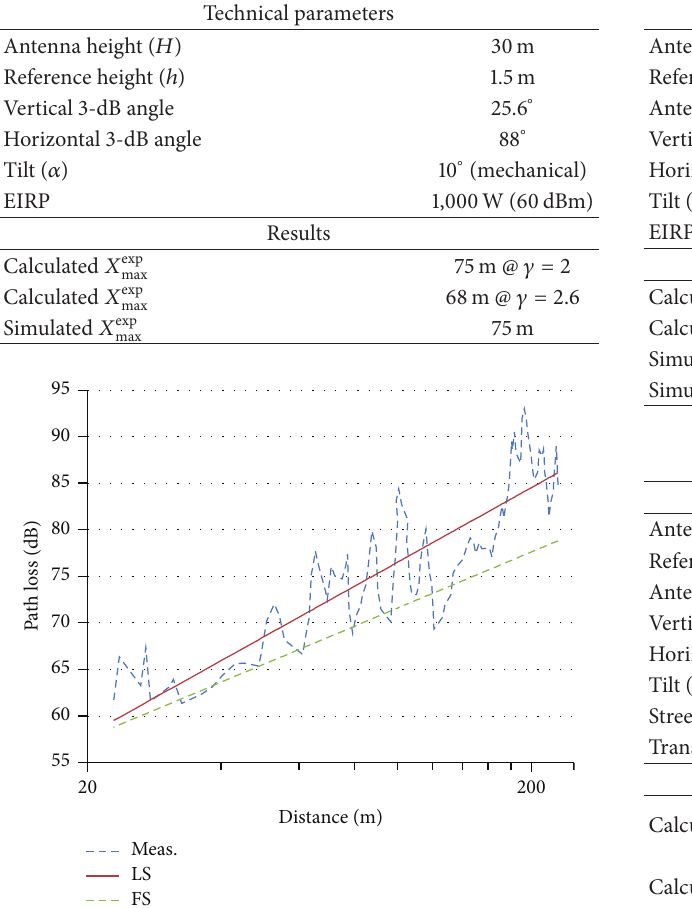
Table 2: BS 2—300 Slater Street—Ottawa.